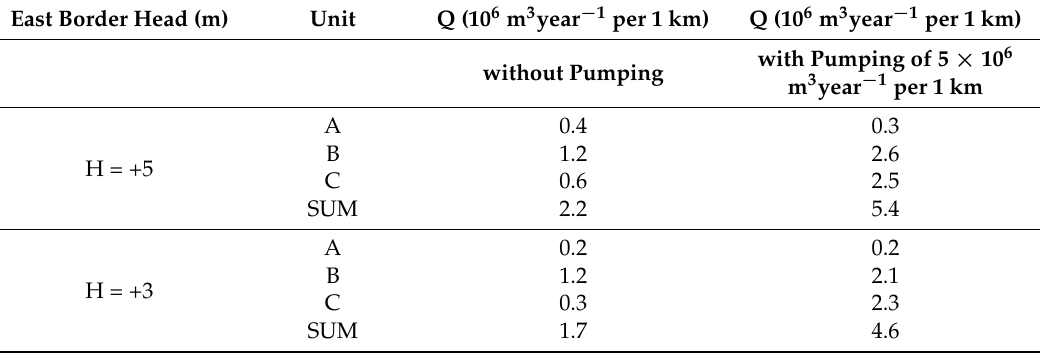
Table 5. Calculated water input from the Late Cretaceous aquifer to the coastal aquifer in the pristine case and after pumping of 5 × 10 6 m 3 year − 1 per 1 km coast from the coastal aquifer, with eastern boundary level of +5 m and + 3